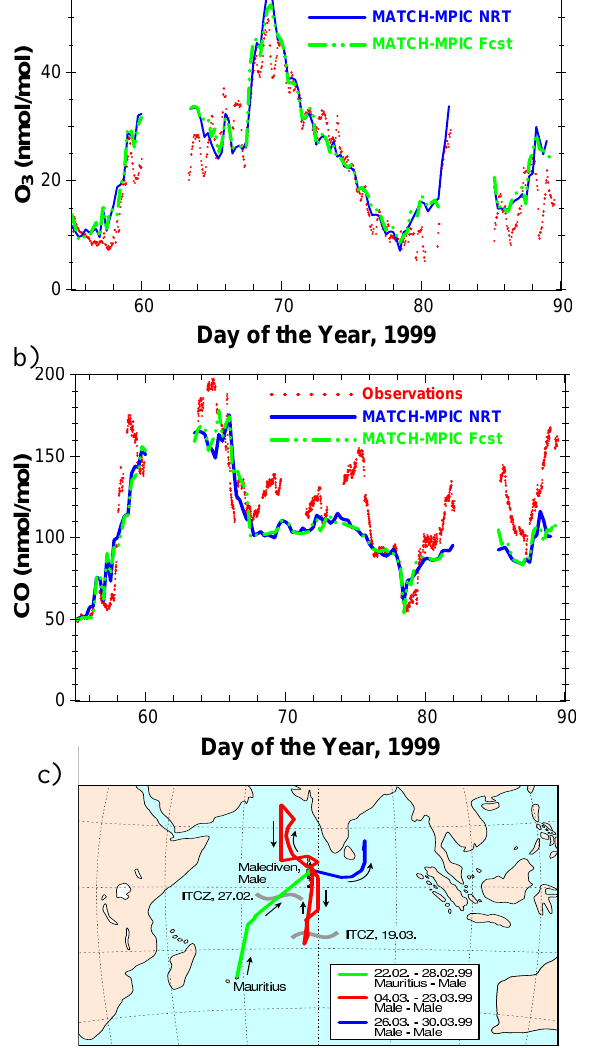
Fig. 22. Observations (dots) and modelled values (solid lines, from MATCH-MPIC) of (a) O 3 and (b) CO during the 1999 RV Ronald H. Brown cruise; the cruise route is depicted in panel (c) , with indicators for the two encounters with the ITCZ: the crossing on 27 February 1999 (Julian day 58), and the brief encounter on 19 March 1999 (Julian day 78) (from Lawrence et al., 2003a, copy- right 2003 by the European Geophysical Union, reproduced with permission).